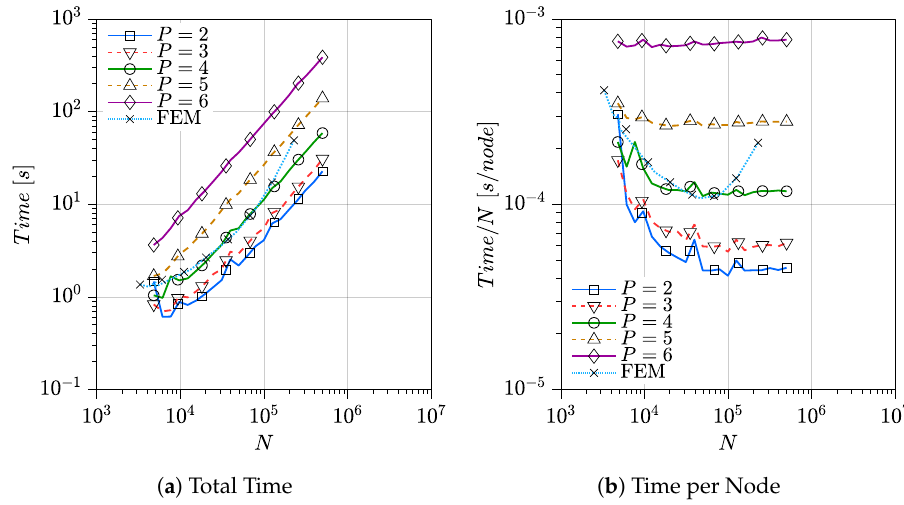
Figure 5. Total time required for the final solution, Ω : sphere, Dirichlet